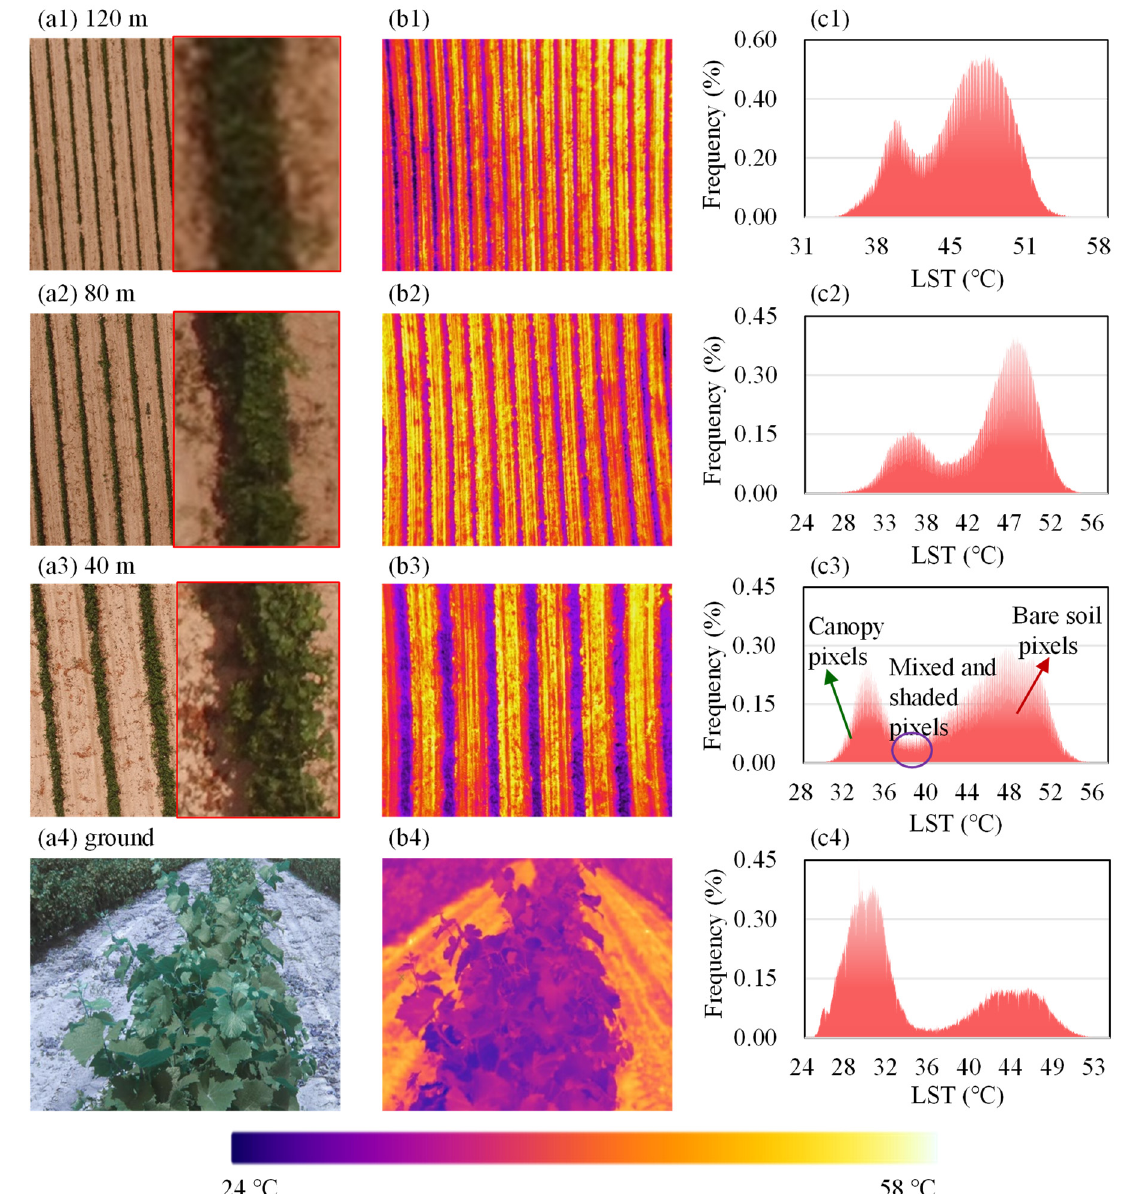
Figure 6. Map of the ( a ) visible light, ( b ) land surface temperature (LST), and ( c ) their frequency histograms of vineyard at different observation heights: (1) 120 m; (2) 80 m; (3) 40 m; and (4) 2 m. The data of 120 m were taken at 13:00 on 12 July 2019; 80 m and 40 m were the samples acquired at 13:00 and 13:30 on 16 July 2019, respectively; the ground data were acquired at 13:14 on 16 July 2019.